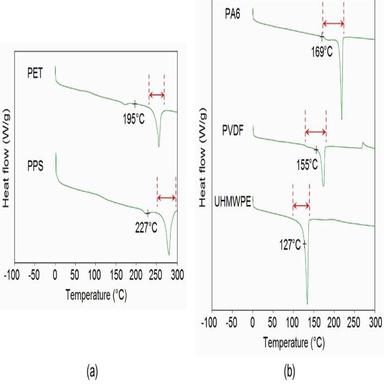
DSC curves of investigated semi-crystalline materials, first heating cycle, 5 �C/min heating rate, 0–300 �C temperature range. Friction/bulk temperature during wear test indicated by black cross, melting range is inside the red marked area. Adhesive-abrasive group is represented by (a), while adhesive group is represented by (b). (For interpretation of the references to colour in this figure legend, the reader is referred to the Web version of this article.)